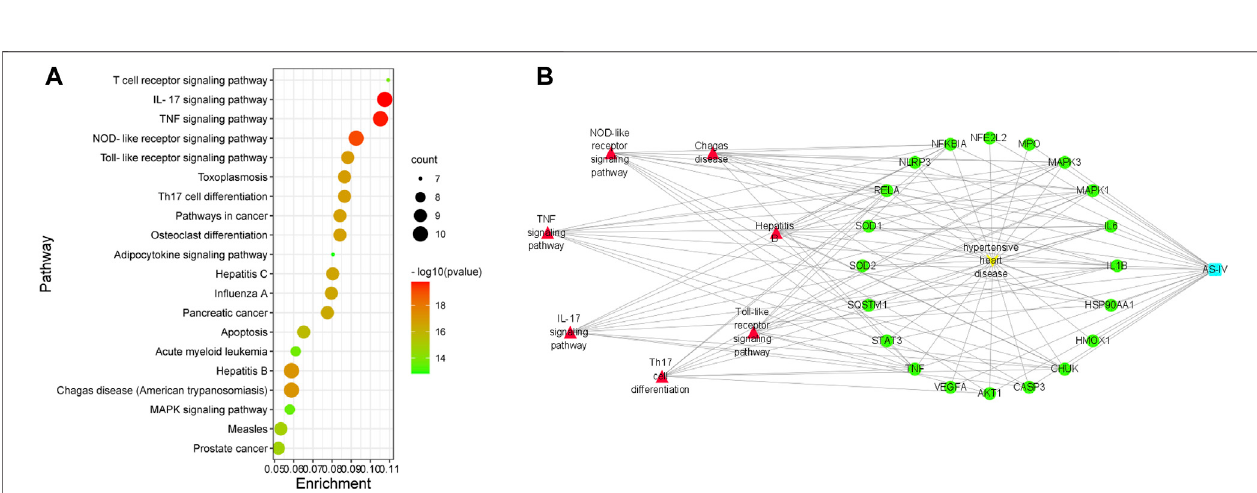
FIGURE 2 | KEGG pathway enrichment analysis of top 20 genes. (A) Compound-targets-pathways-disease network: blue node is AS-IV. (B) Yellow node is hypertensive heart disease; green nodes represent 20 genes; red nodes represent seven potential signaling pathways; these lines indicate the interactions between